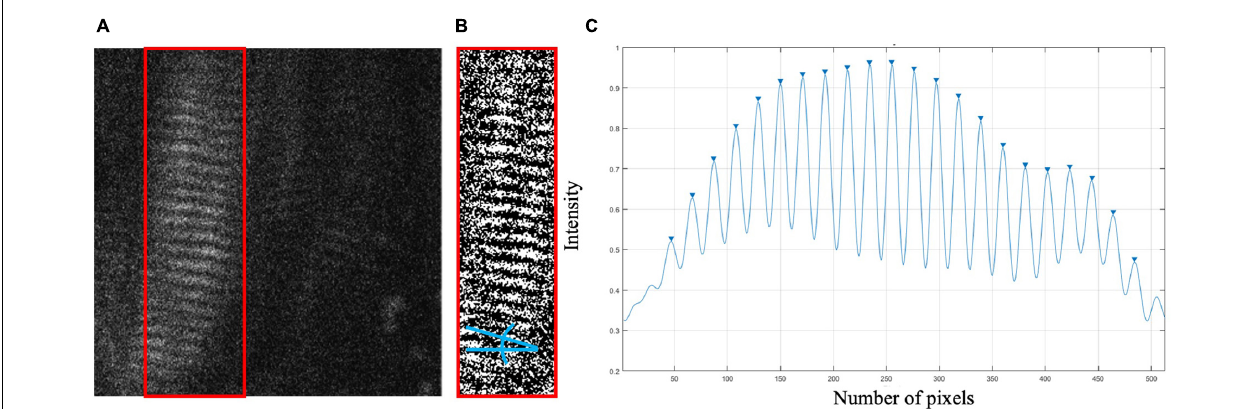
FIGURE 1 | (A) Sample raw SHG image of in vivo biceps brachii sarcomere data (512 pixels × 512 pixels, 82 µ m × 82 µ m). Canny edge detection selected region enclosed by red box. (B) Binarized selected region with blue lines indicating the angle relative to horizontal. (C) Pixel vs. intensity distribution where A-bands are represented by peaks.